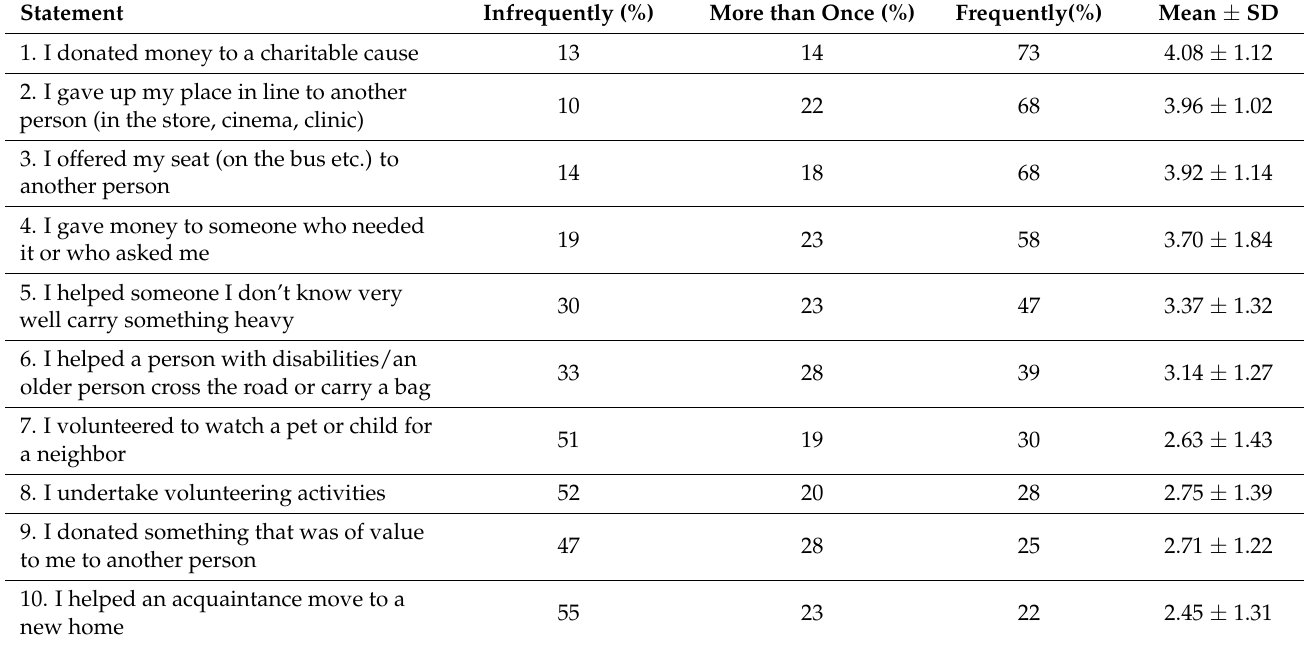
Table A1. Distribution of responses to the altruism questionnaire.